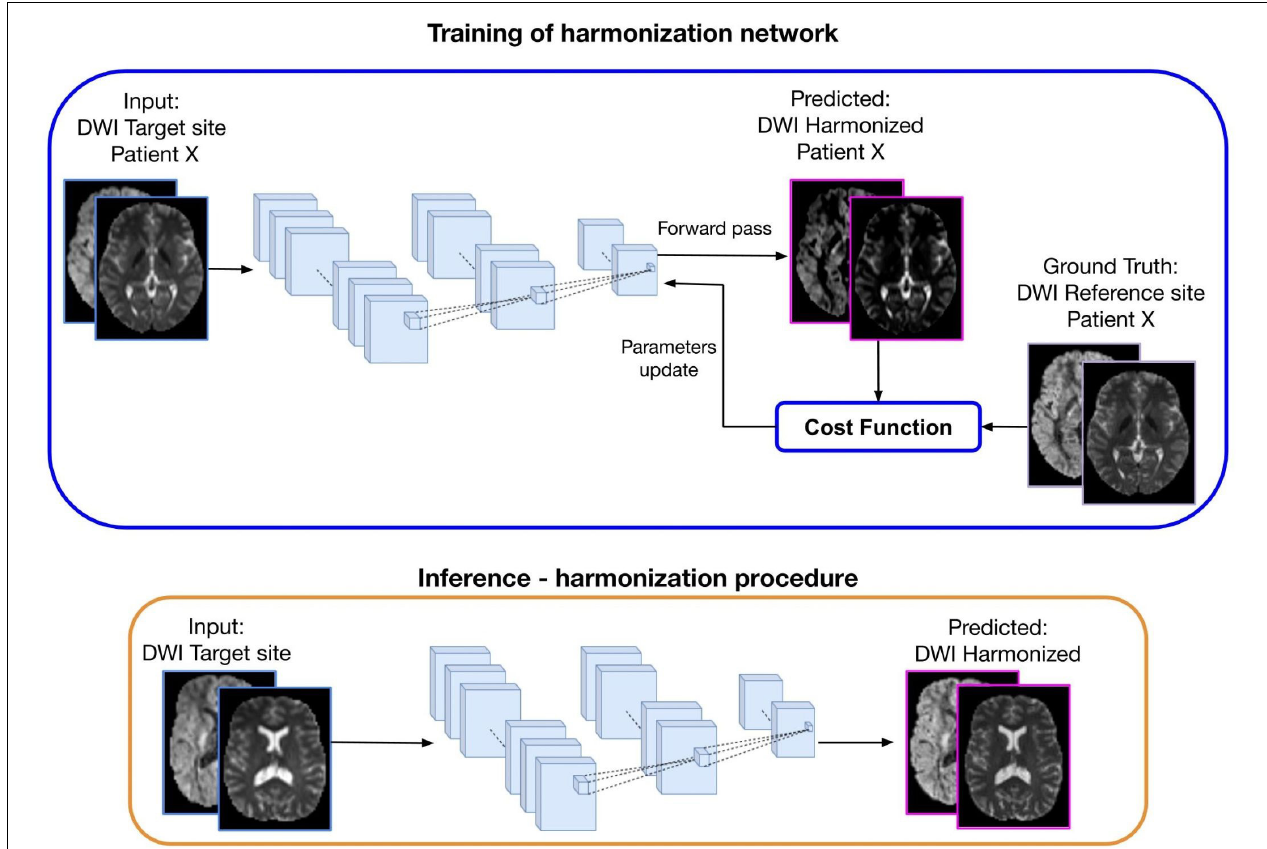
FIGURE 4 | Representation of a deep learning approach for diffusion data harmonization. The purpose of the method is to modify the DWI acquired at the target site, to correspond to the DWI of the same subject acquired at the reference site. In the training part, DWI from the target site is used as input and DWI from the reference site as ground truth, for patient X . Matched subjects are used to tune the weights of the harmonization network. During the forward phase, the network produces the predicted harmonized DWI that is compared with the corresponding expected DWI from the reference site. The difference between the predicted and the ground-truth (cost function) is back propagated into the network to update the weights in such a way that the loss decreases and the predicted harmonized DWI is closer to the ground truth. In the inference step, the trained network is used to generate the predicted harmonized DWI from unseen DWI data of the target site, which then become comparable to the DWI from the reference